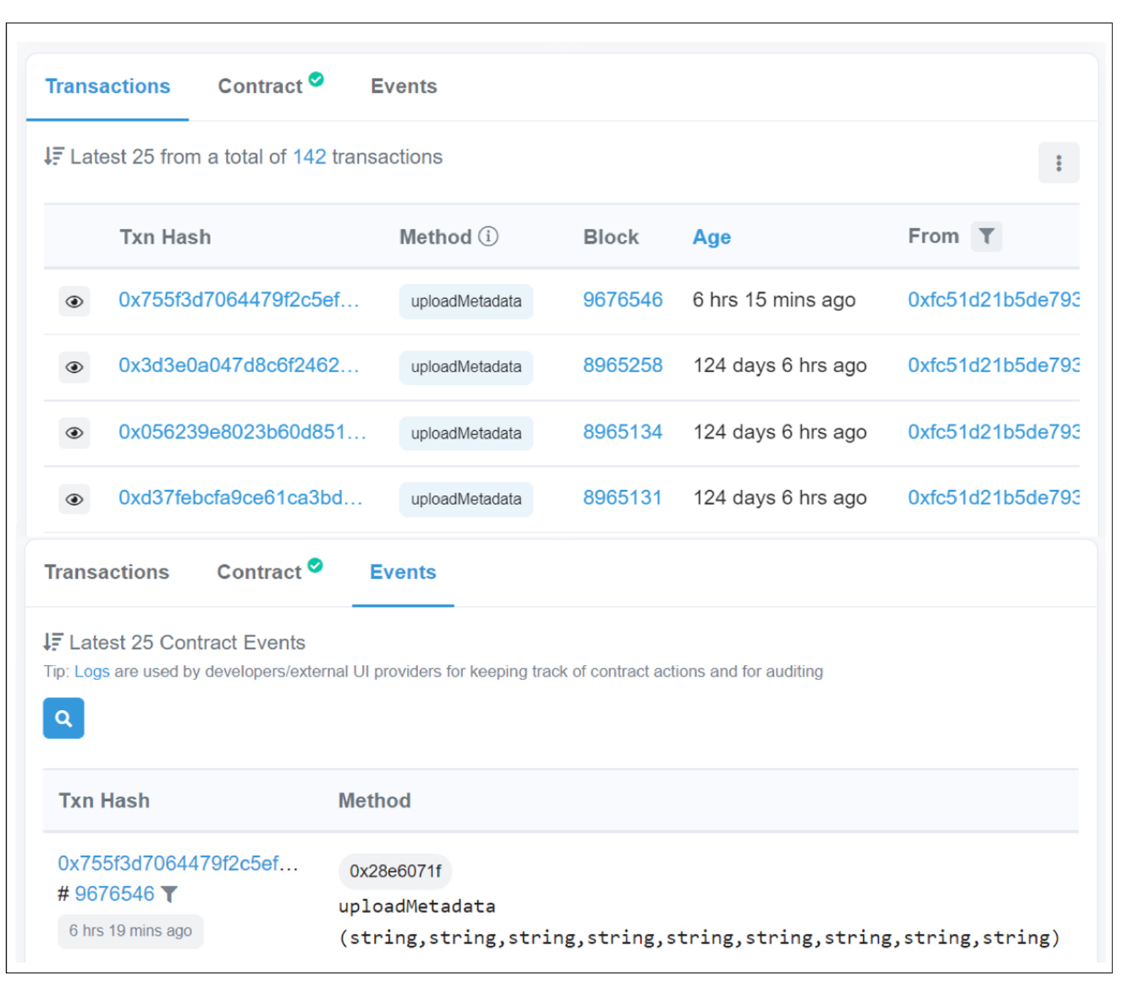
Figure 13. Blockchain Event and Transactions.